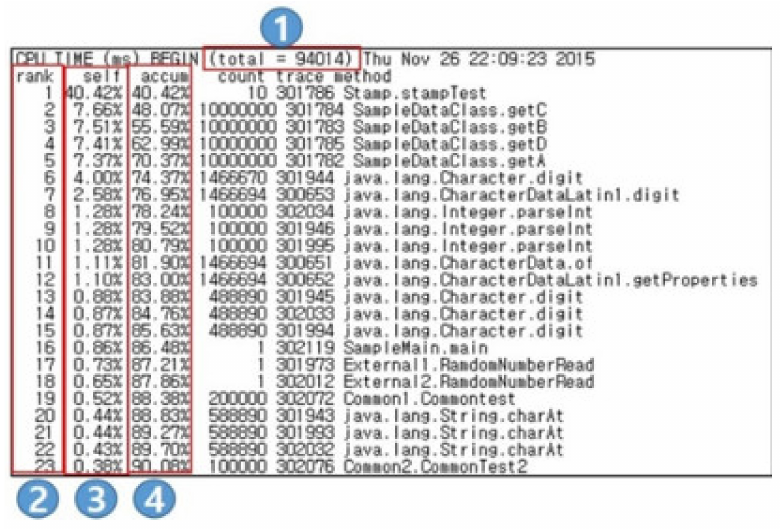
Figure 7. Result of CPU usage time profile